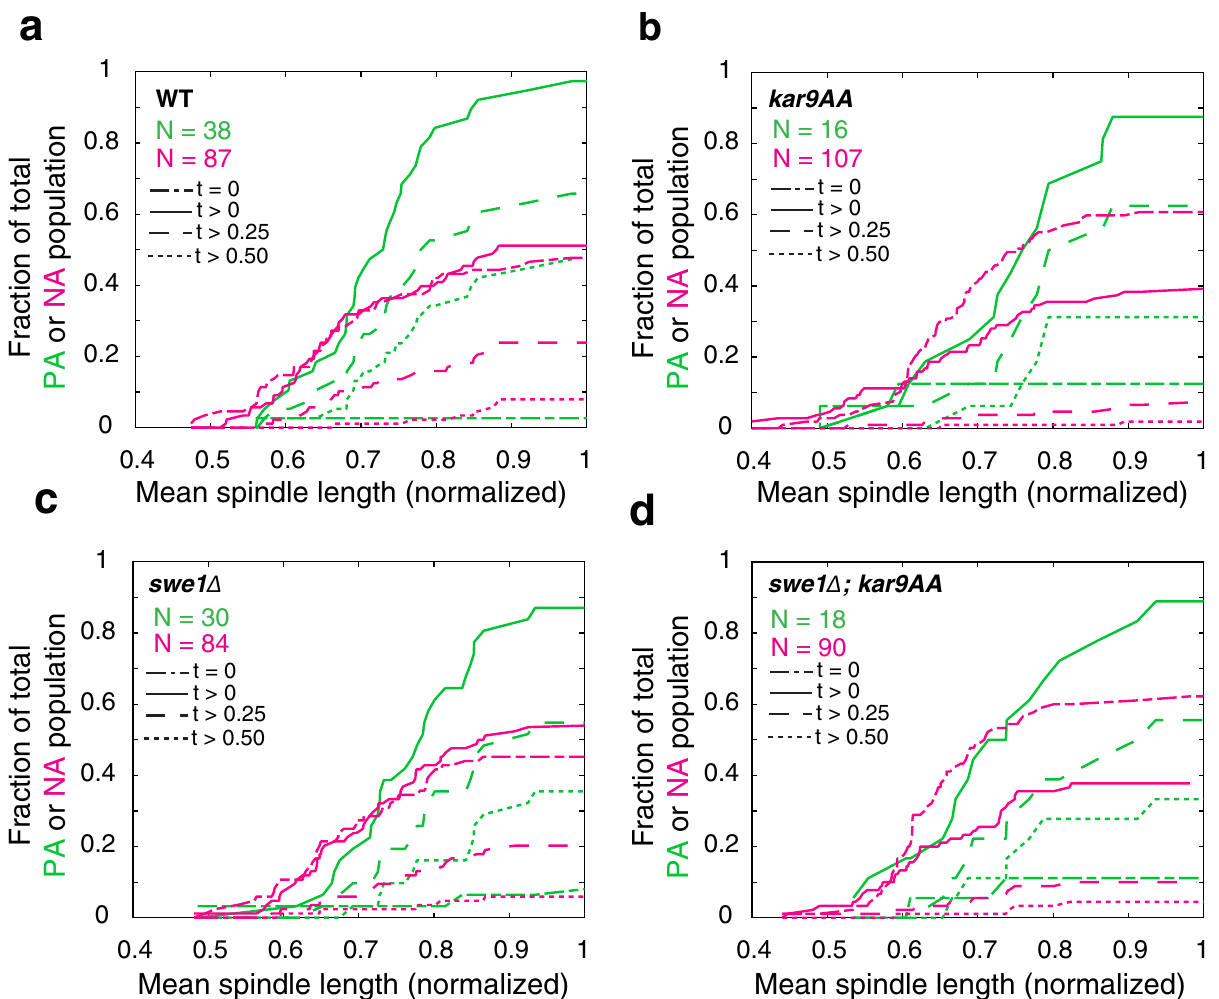
Figure 6. Deletion of Swe1 delays spindle alignment by reducing Kar9 residence time in the bud ( a ) The number of WT spindles displaying non-zero residence times increases with spindle length. ( b ) Similarly, residence time in the bud is correlated with metaphase progression in kar9-AA cells. ( c ) swe1∆ consistently display delays in the accumulation of non-zero residence times, irrespective of the state of alignment. ( d ) swe1∆; kar9-AA behave like the kar9-AA